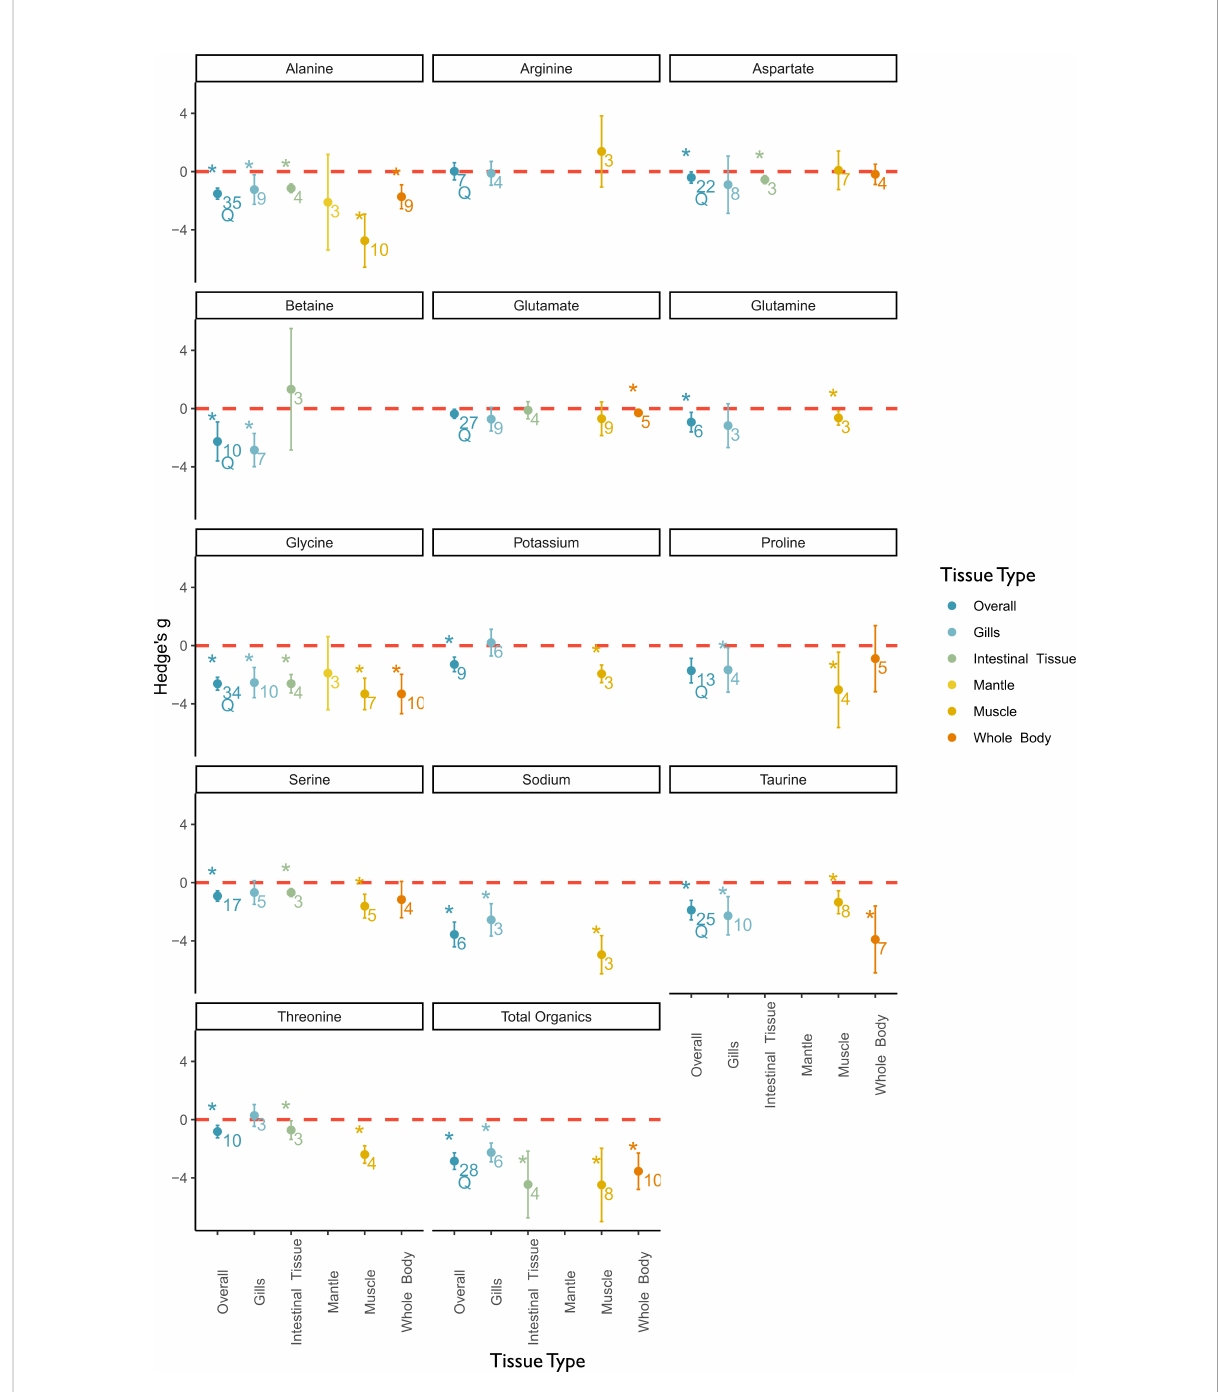
FIGURE 6 Meta-analysis results of the effect of low salinity stress on osmotic compounds by the categorical moderator variable tissue type. The panel includes a separate plot for each measured solute. In each plot, the overall effect and the subgroups are depicted on the x-axis and the effect sizes as Hedge ’ s g on the y-axis. A positive value indicates a positive salinity effect (i.e., an increase in concentration at decreasing salinities), whereas a negative value indicates a negative salinity effect on solute concentration. The overall mean effect size might differ from Figure 4 due to changed sample size when subgroups could not be included due to small sample size. The mean effect size for each tissue type is depicted as a circle with the error bars indicating robust con fi dence intervals (95%). An asterisk above the overall effect size indicates tissue type as a signi fi cant moderator. Asterisks above the individual tissue types indicate a signi fi cant salinity effect for that speci fi c subgroup. Numbers below circles indicate k — the number of studies. Q indicates signi fi cant residual heterogeneity as tested with the mixed effects